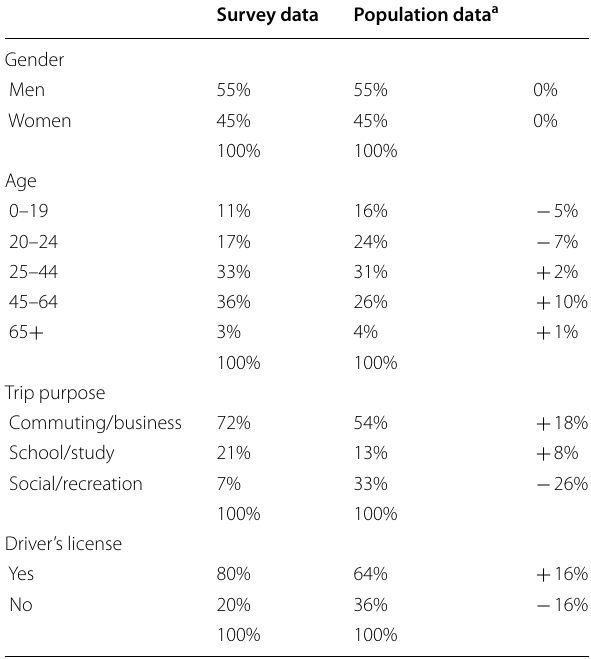
Table 1 Survey data compared with population